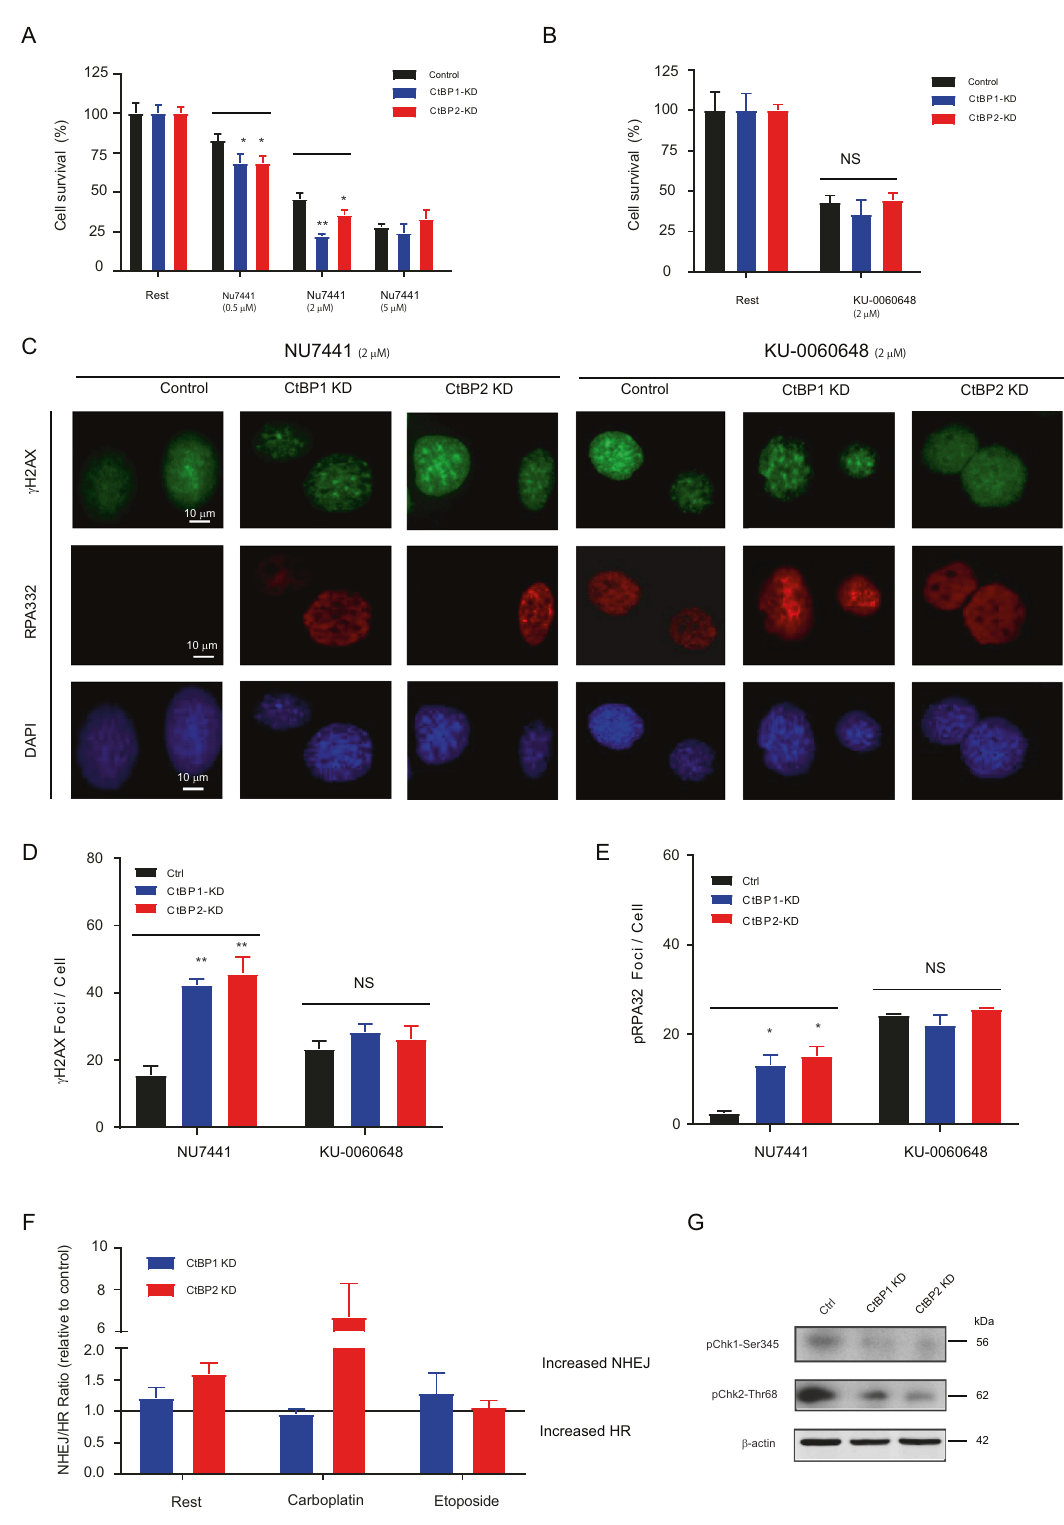
ionizing radiation or UV, phosphorylate level of Chk2-Thr68 increased, causing the pathway switch from the NHEJ to error- free HR. DNA-PK controlled the Chk2-Thr68 phosphorylation level and regulated the Chk2 – BRCA1 pathway to reverse pathway shift and ensured chromosomal stability [33]. We proposed that CtBP2 would play a dominant role in